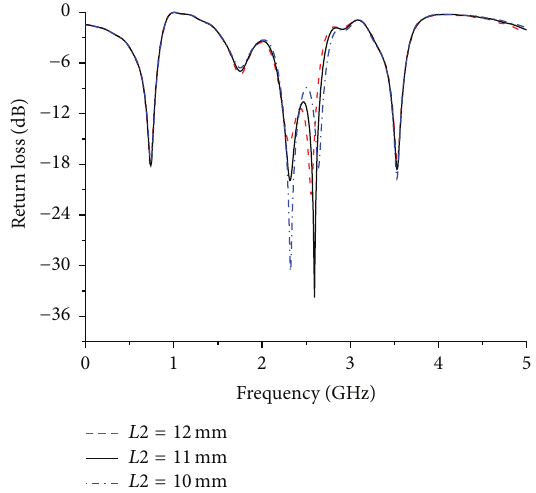
Figure 3: Simulated return loss characteristics for the proposed antenna for various values of 𝐿2